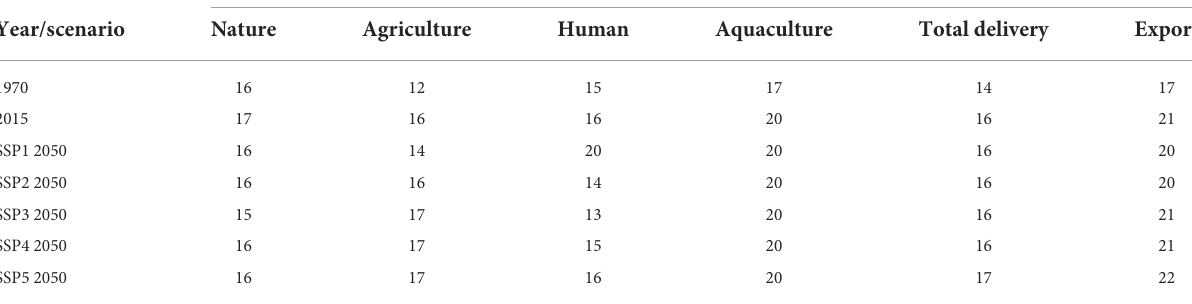
TABLE 2 Molar N:P ratio for the different sources of the global delivery, total global delivery and global export of the rivers for the years 1970 and 2015 and for 2050 for different SSP scenarios. N:P ratio Year/scenario Nature Agriculture Human Aquaculture Total delivery